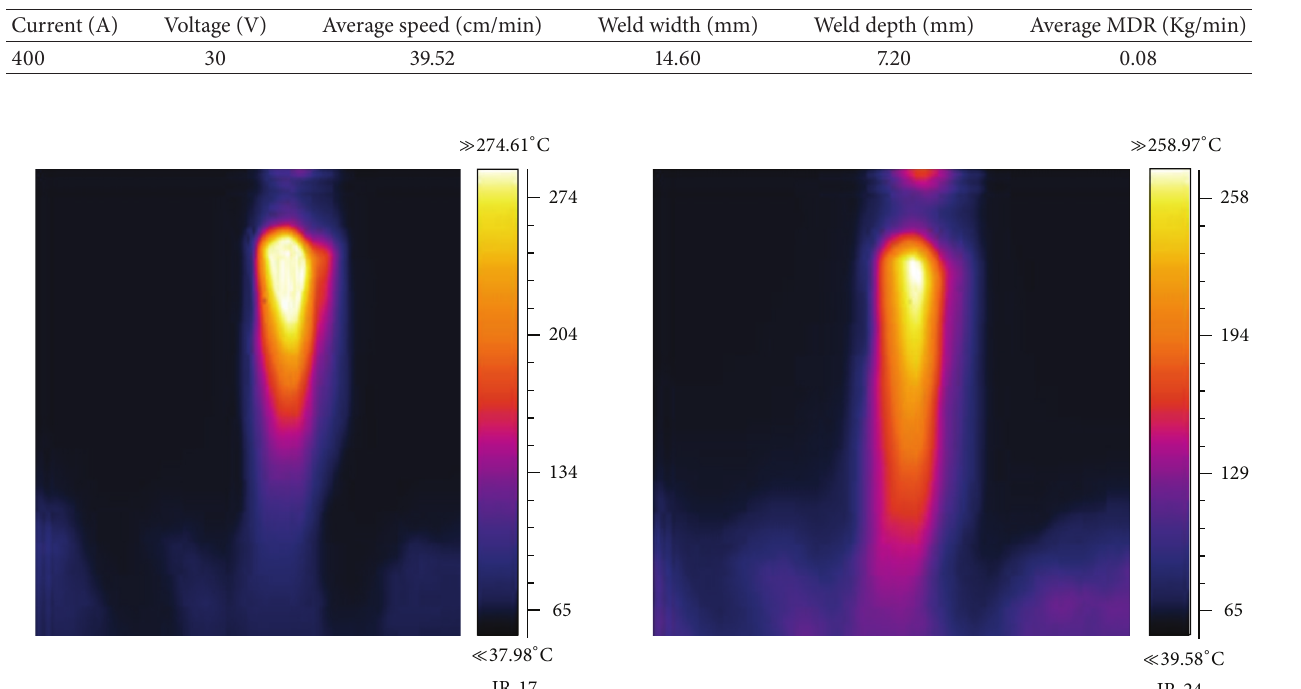
contact between the U-shaped sheet metal and the plate in addition to the insulation provided at the bottom of U-piece ensured minimum heat transfer to the sheet metal, while it was in contact with the weld plate.